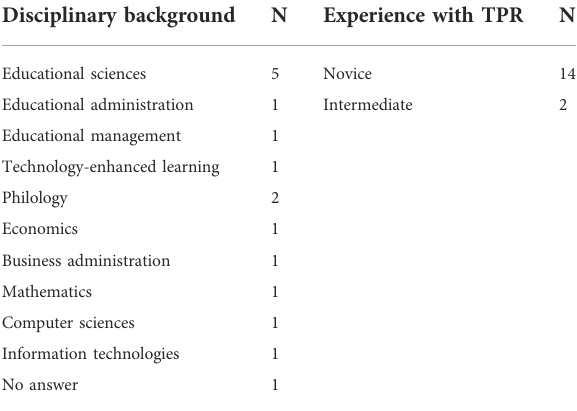
TABLE 2 The sample demographics (disciplinary background, experience with TPR). Disciplinary